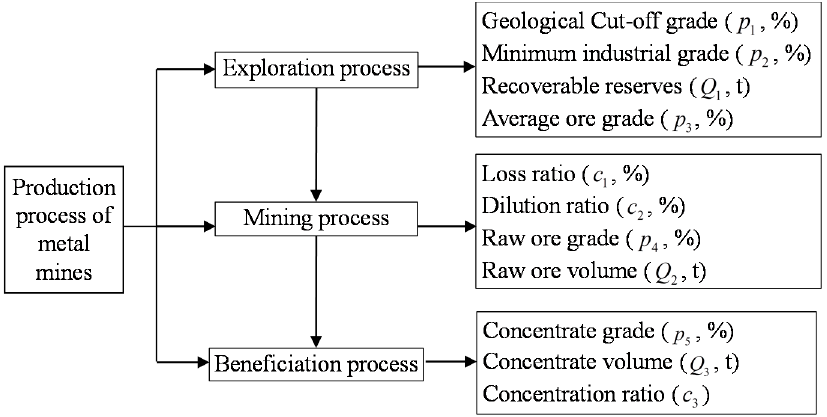
Figure 1. Production process of metal mines.